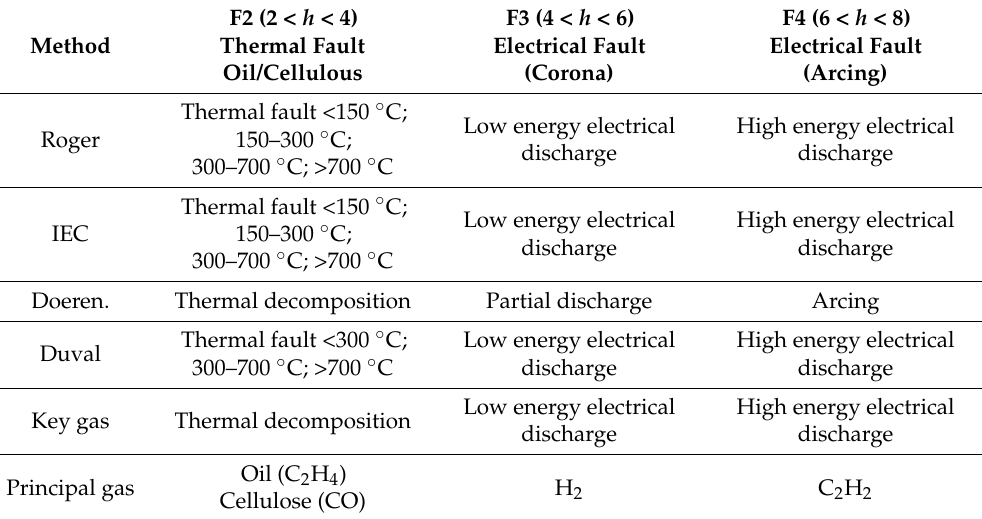
Table 2. Possible fault types within transformer oil